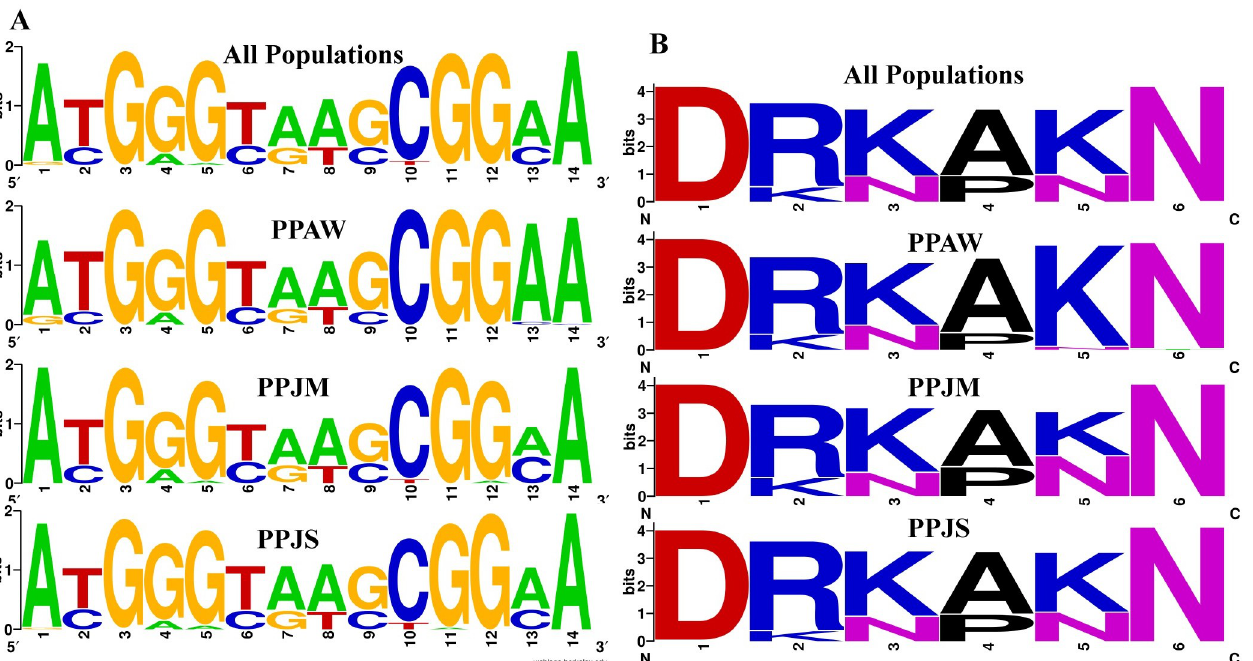
Fig 2. PpSP12 nucleotide and amino acid variation. (A) Weblogo illustrating the relative frequencies of nucleotide polymorphisms in wild caught P . papatasi populations from PPAW, PPJM, and PPJS. (B) Weblogo illustrating the relative frequencies of amino acid polymorphisms in wild caught P . papatasi populations from PPAW, PPJM, and PPJS.